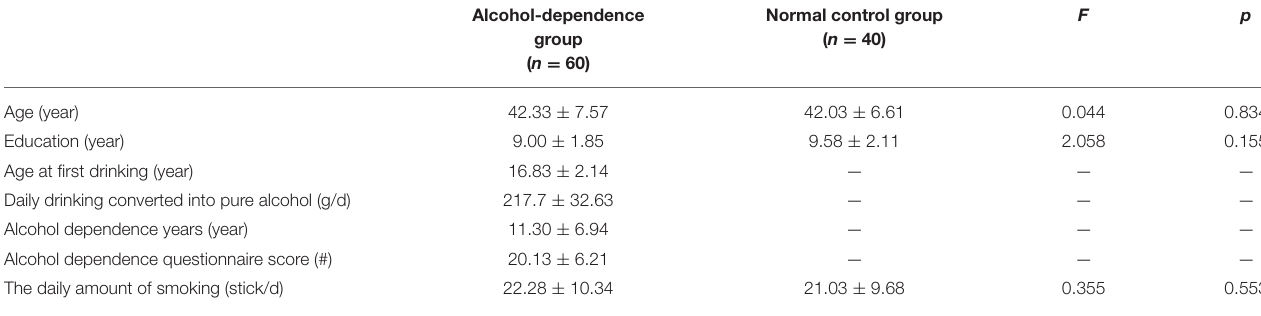
TABLE 1 | General demographic data and alcohol use in the alcohol-dependence group and the normal control